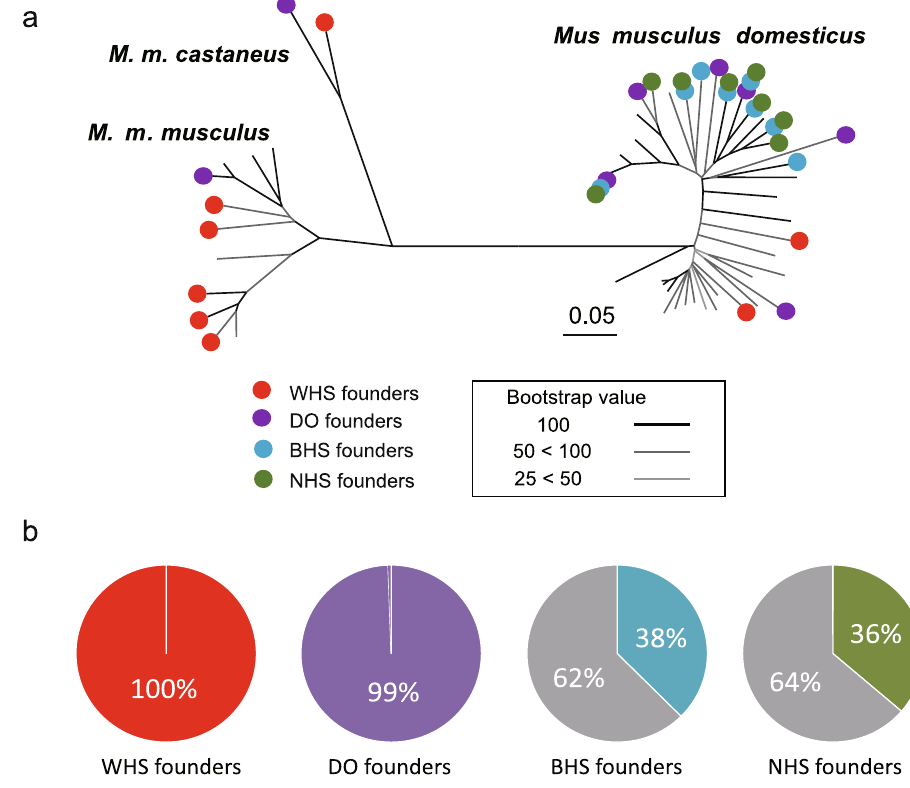
Figure 1. Genetic characteristics of the mouse strains used to establish the wild-derived heterogeneous stock (WHS). ( a ) Neighbor-joining tree constructed using single nucleotide polymorphism (SNP) data from eight WHS founder strains and other inbred strains. The bootstrap test was performed 1,000 times. A total of 10,594 SNPs obtained using the MegaMUGA array were used. Because the SNPs of the array were selected to show genetic differences among M. m. domesticus subspecies, the genetic differences among M. m. musculus subspecies appear to be smaller than the actual genetic distances. ( b ) Circular charts indicating the percentages of the 10,594 in each stock showing polymorphisms for the eight founder strains. The grey section indicate percentages of SNPs showing no